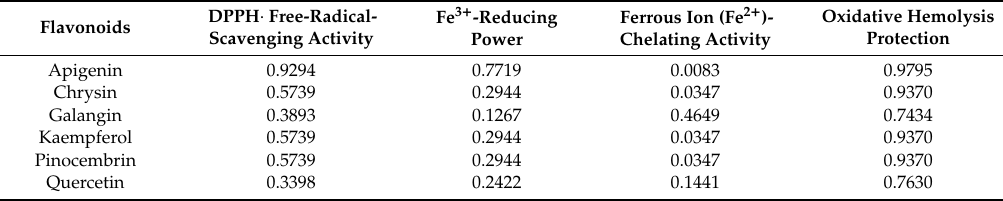
Table 5. The e ff ect of flavonoid concentrations in propolis extracts on antioxidant activity. Table 5. The effect of flavonoid concentrations in propolis extracts on antioxidant activity.